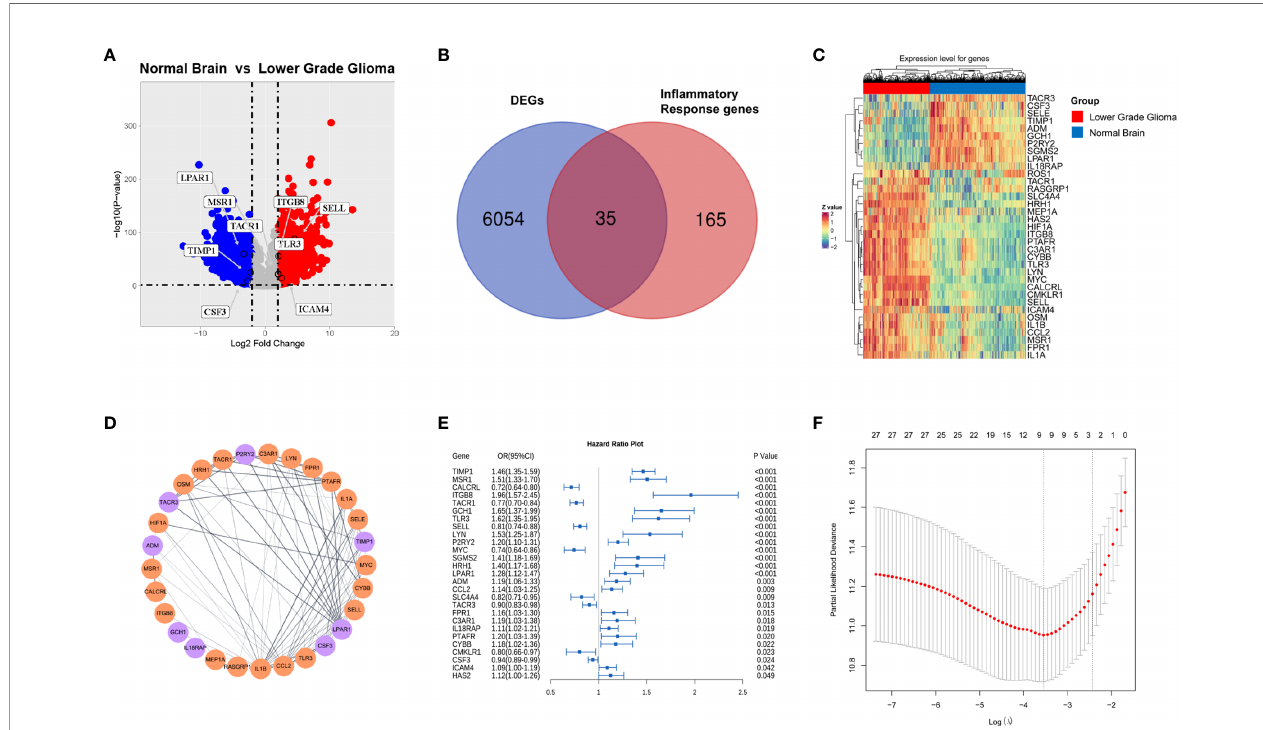
FIGURE 2 | Identi fi cation of in fl ammation-related genes with prognostic signi fi cance. (A) Volcano plot of differentially expressed genes analysis in primary lower grade glioma (TCGA cohort) compared with normal brain (GTEx) (red dots, upregulated genes; blue dots, downregulated genes); (B) Venn diagram of overlapping genes between the DEGs and IRGs; Gene expression heatmap (C) and PPI network (D) of overlapping genes. (E) Forest plot of overlapping genes correlated with survival in the TCGA cohort (p value <0.05). (F) Cross-validation for tuning parameter (lambda) screening in the lasso regression